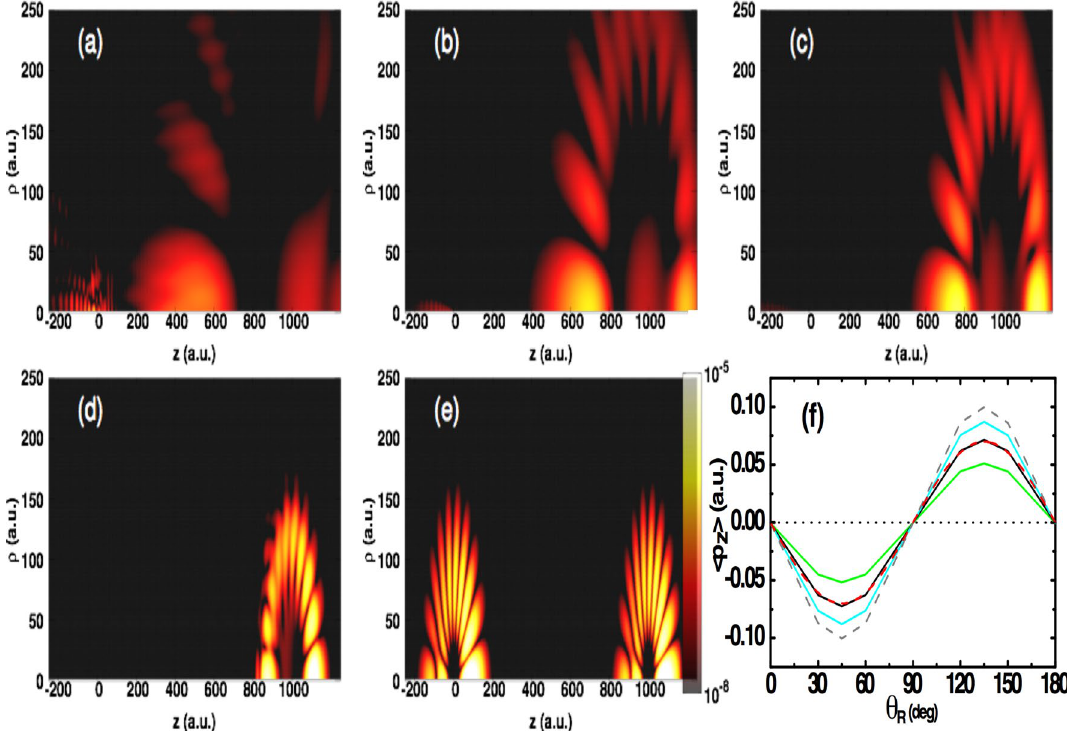
Figure 2. ( a )–( e ) Electron density in the ρ - z plane at the end of the probe pulse for an initial phase of φ( t i ) = 0 and for the polar angle θ R = π/ 4 , respectively at different angular frequencies and peak intensities: ( a ) ω = 0.0006 (4.78 10 10 ), ( b ) 0.00088 (2.45 10 11 ), ( c ) 0.00117 (7.66 10 11 ), ( d ) 0.0059 (4.78 10 14 ) and ( e ) 0.057 a.u. (4.26 10 18 W/cm 2 ). For reference, the initial state before the probe pulse is introduced is shown in the left-hand side of figure ( e ). ( f ) Expectation value of the momentum < p z > as a function of the polar angle θ R at different initial phases φ = π/ 6 (green solid line), φ = π/ 4 (black solid line), φ = π/ 3 (cyan solid line) and φ = π/ 2 rad (dashed gray line). The peak intensity is fixed at 4.26 10 18 W/cm 2 and angular frequency is 0.057 a.u. Also is shown the data from the simple model b cos (φ( t f ) + φ 0 ( t f )) sin ( 2 θ R ) for φ = π/ 4 rad (dashed red line) (see text). The dotted line is for